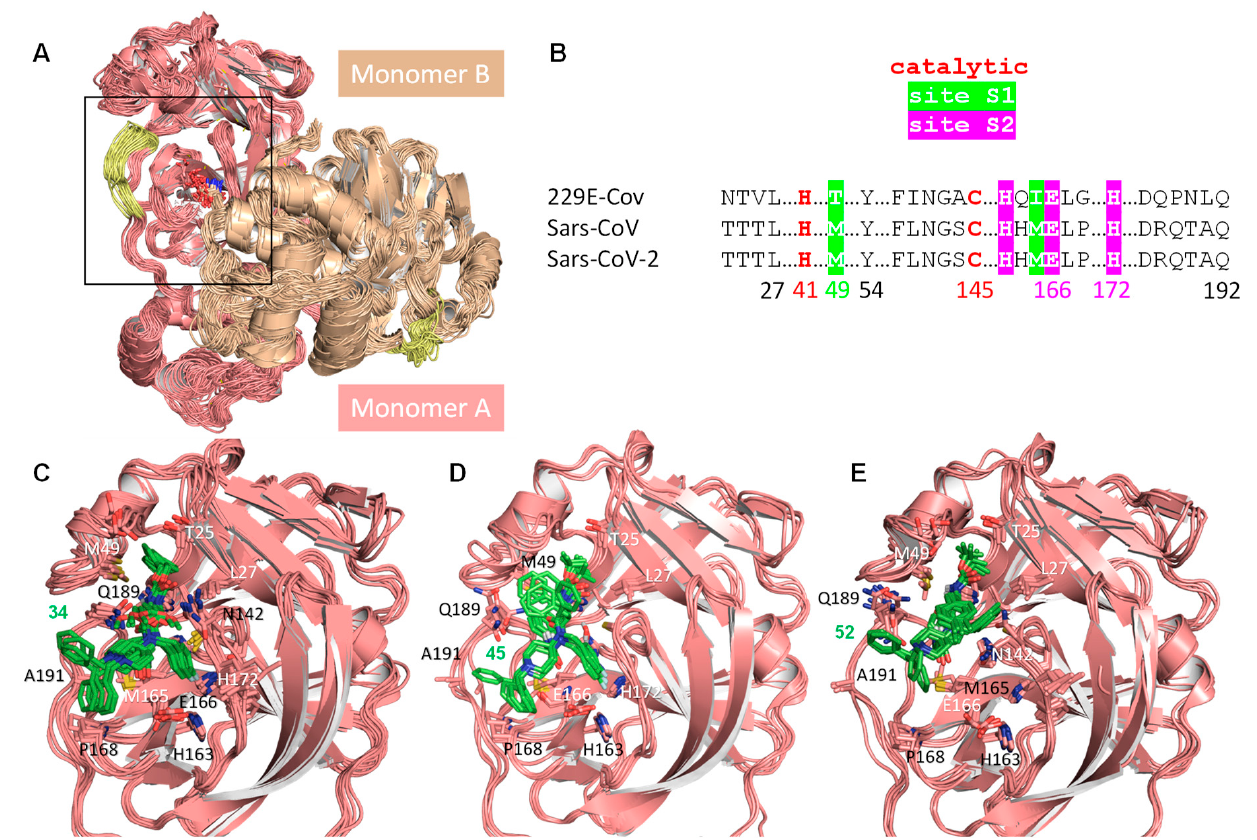
Figure 4. Ribbon representation of chymotrypsin-like protease M pro from SARS-CoV-2. ( A ) Overlay of 30 snapshots taken at regular intervals from the unrestrained molecular dynamics simulation in water lasting 150 ns. Each monomer is displayed in a different color and the 187 Asp-Ala 193 stretch is highlighted in yellow. ( B ) Alignment of active site amino acids from HCoV-229E, SARS-CoV and SARS-CoV-2 M pro enzymes that are proposed to have a direct bearing on ligand binding, as discussed in the text. ( C – E ) Theoretical models of one monomer of SARS-CoV-2 M pro (ribbon with C atoms colored in pink) in complex with compound 34 ( C ), 45 ( D ) and 52 ( E ); the region displayed corresponds to the boxed area in ( A ). Ligands are shown as sticks with carbon atoms colored in green. Each set of five superposed structures represents a conformational ensemble made up of snapshots taken every 5 ns from the post-equilibrated 75–100 ns interval of the simulated trajectories and then cooled down to 273 K and energy minimized. For reference, some of the residues closest to the ligands have been labeled. Water molecules are not displayed for enhanced clarity.